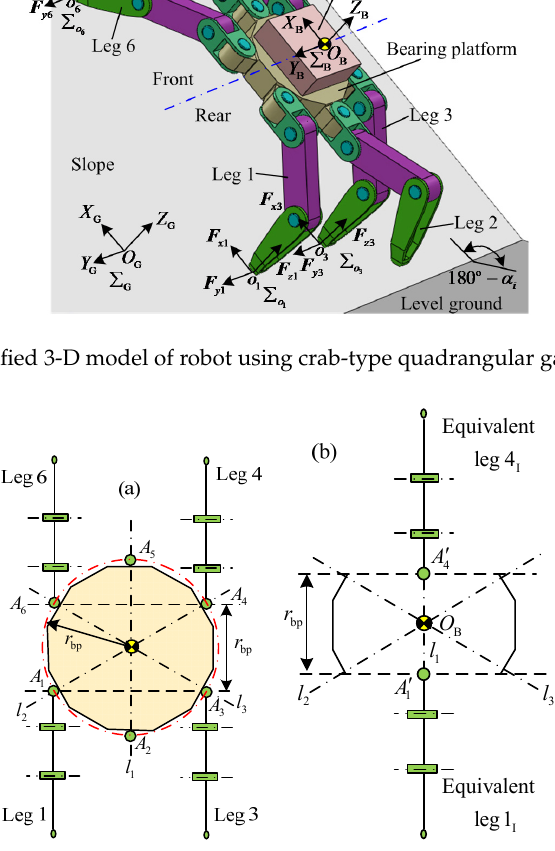
Figure 4. Working condition I of support phase: ( a ) support phase involving legs 1, 3, 4 and 6; and ( b ) equivalent support phase of legs 1, 3, 4 and 6.